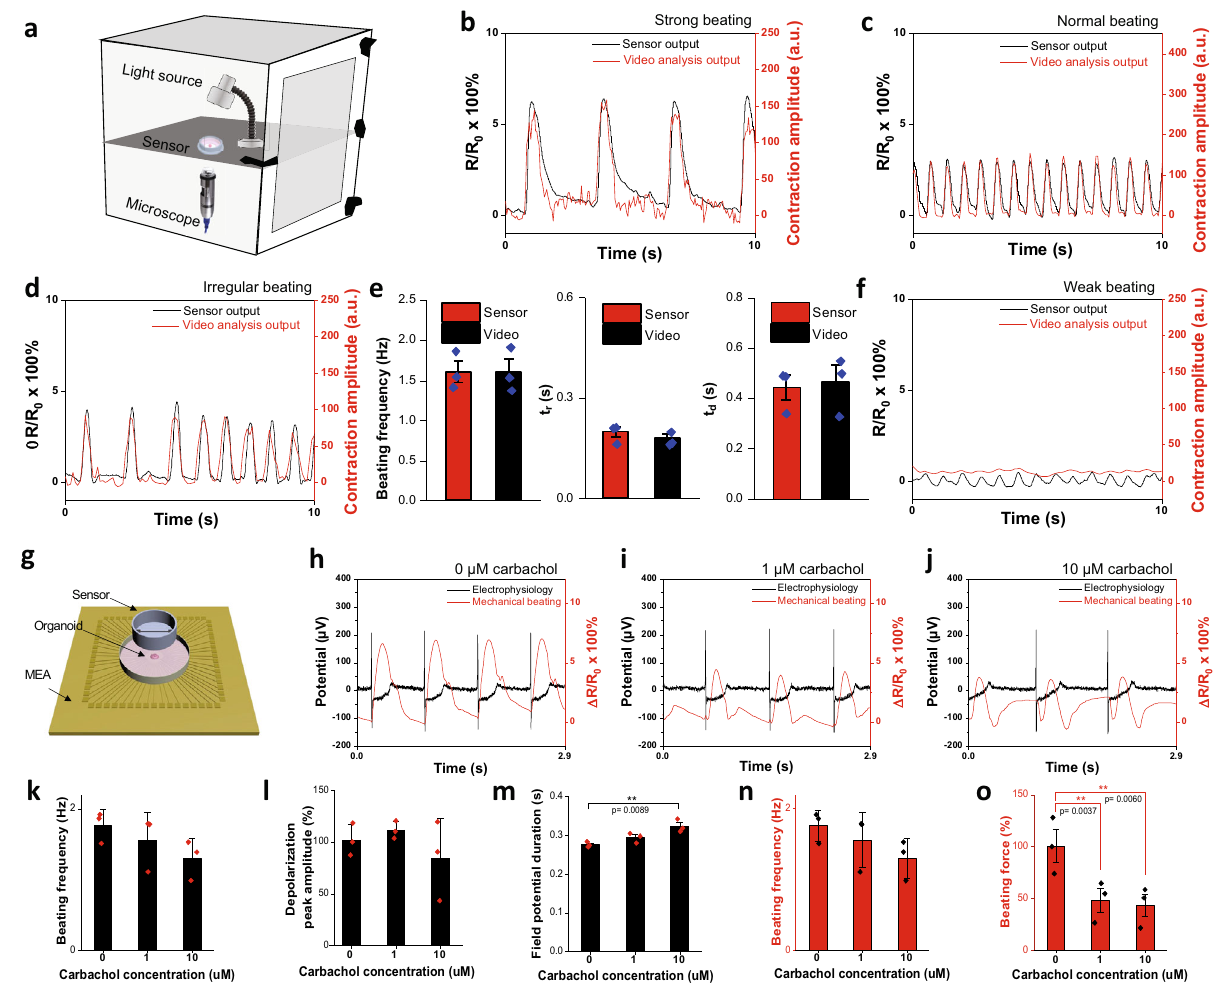
Fig. 2 | Simultaneous optical/force measurements and electrophysiological/ force measurements. a Schematic of the simultaneous optical/force measure- ments set-up. b – d Simultaneous optical/force measurements with strong beating ( b ), normal beating ( c ), and irregular beating ( d ), e Changes in beating frequency (left), rise time (t r , middle), and decay time (t d , right) of the sensor and video output owing to the contractionand relaxation of the 3-day old cardiac organoids ( n =3). f Simultaneousoptical/forcemeasurementswithweakbeating. g Schematic of the simultaneous electrophysiological/force measurements set-up. h – j